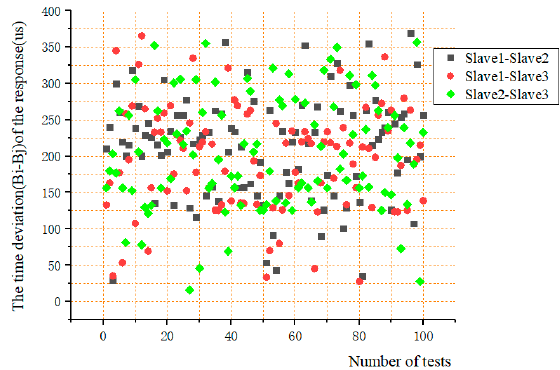
Figure 17. The results of the time differences required for two slaves to execute synchronous code.